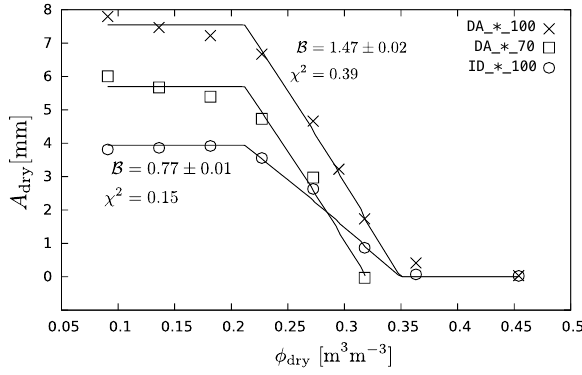
Figure 9. Fit of the advection in cases DA_*_100 , DA_*_70 and ID_*_100 . Symbols indicate the values obtained from the simu- lations while lines represent the fit performed using Eq. (9). The obtained values of B are reported in the insets, together with the absolute error and the χ 2 value (see Fig. 8 for the definition). Note that for the DA_ * _100 and DA_ * _70 cases the fits yielded simi- lar results; for this reason the obtained value for B is reported only